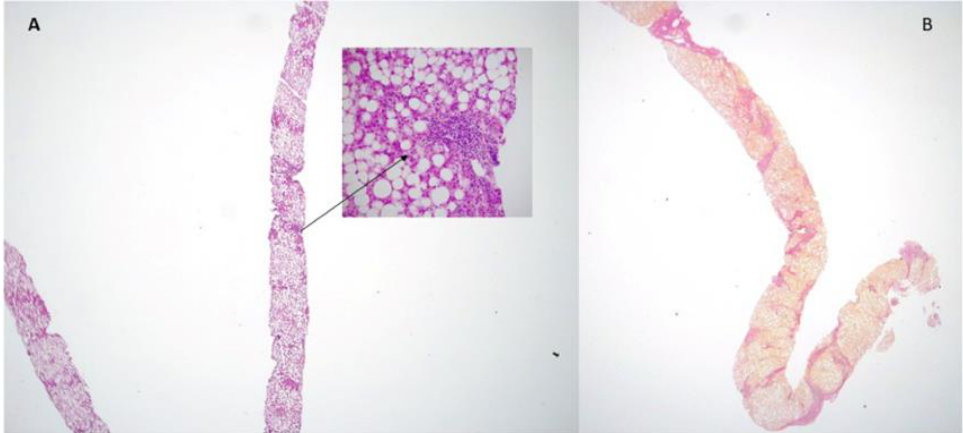
Figure 3. ( A ) NASH with severe steatosis and moderate portal inflammation (arrow) at presenta- tion (H&E; original magnification 1.2×; insert original magnification 40×. ( B ) The same patient showed cirrhosis in the follow up biopsy performed 4 years later (Van Gieson’s stain; original magnification 2.5×).